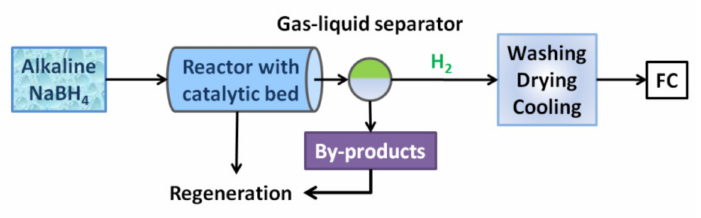
Figure 3. A schematic diagram of the hydrogen generation system with a flow